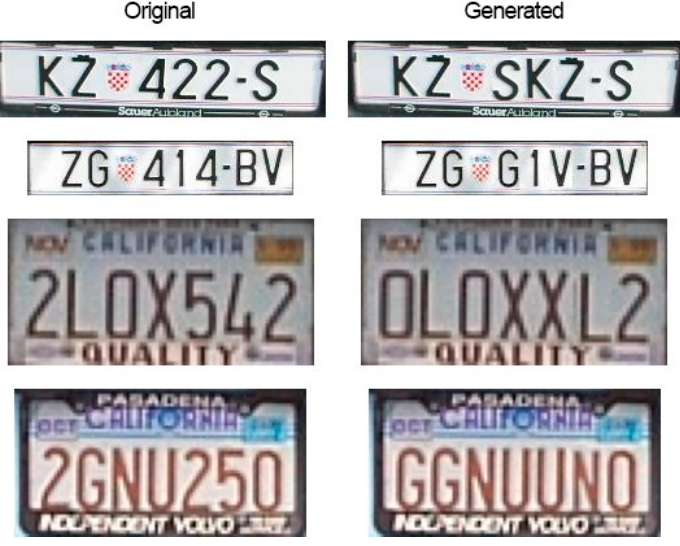
Figure 2. Data generation using